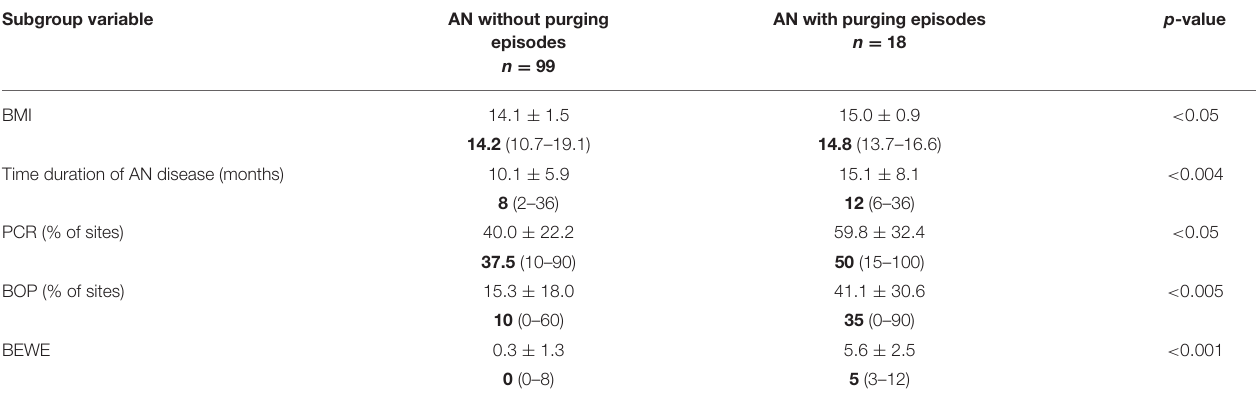
TABLE 2C | Comparison of duration of disease, BMI, PCR%, BOP%, BEWE in AN subgroups according to purging episodes. Subgroup